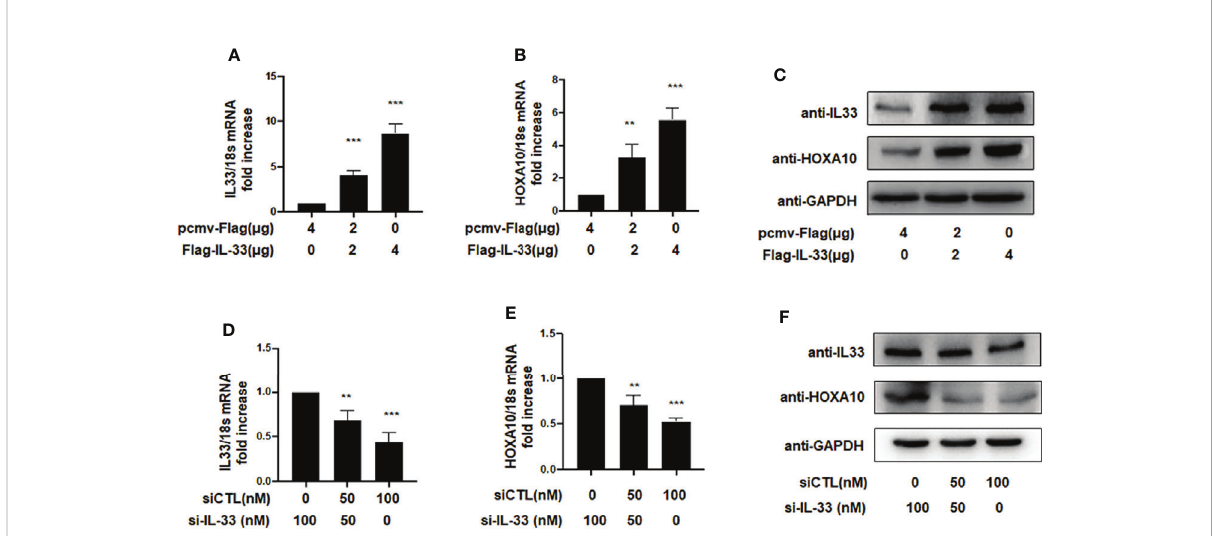
FIGURE 2 IL33 could induce HOXA10 expression. (A) Ishikawa cells were transfected with overexpression plasmid Flag-IL33 or pcmv-Flag negative control. IL33 mRNA levels were measured by qRT-PCR. ***p < 0.001. (B) Ishikawa cells were transfected with overexpression plasmid Flag-IL33 or pcmv-Flag negative control. HOXA10 mRNA levels were measured by qRT-PCR. **p < 0.01, ***p < 0.001. (C) Ishikawa cells were transfected with overexpression plasmid Flag-IL33 or pcmv-Flag negative control. IL33 and HOXA10 protein levels were measured by Western blot. (D) Ishikawa cells were transfected with si-IL33 or negative control. IL33 mRNA levels. were measured by qRT-PCR. **p < 0.01, ***p < 0.001. (E) Ishikawa cells were transfected with si-IL33 or negative control. HOXA10 mRNA levels were measured by qRT-PCR. **p < 0.01, ***p < 0.001. (F) Ishikawa cells were transfected with si-IL33 or negative control. IL33 and HOXA10 protein levels were measured by Western